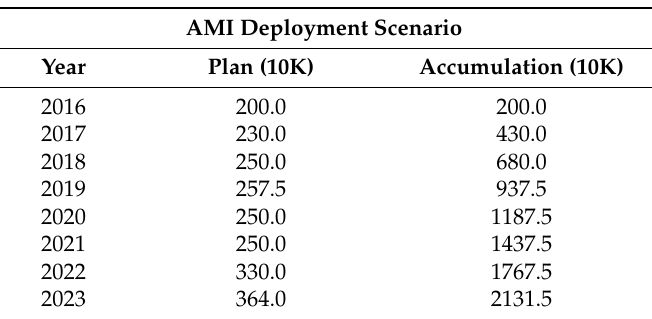
Table 1. AMI Deployment